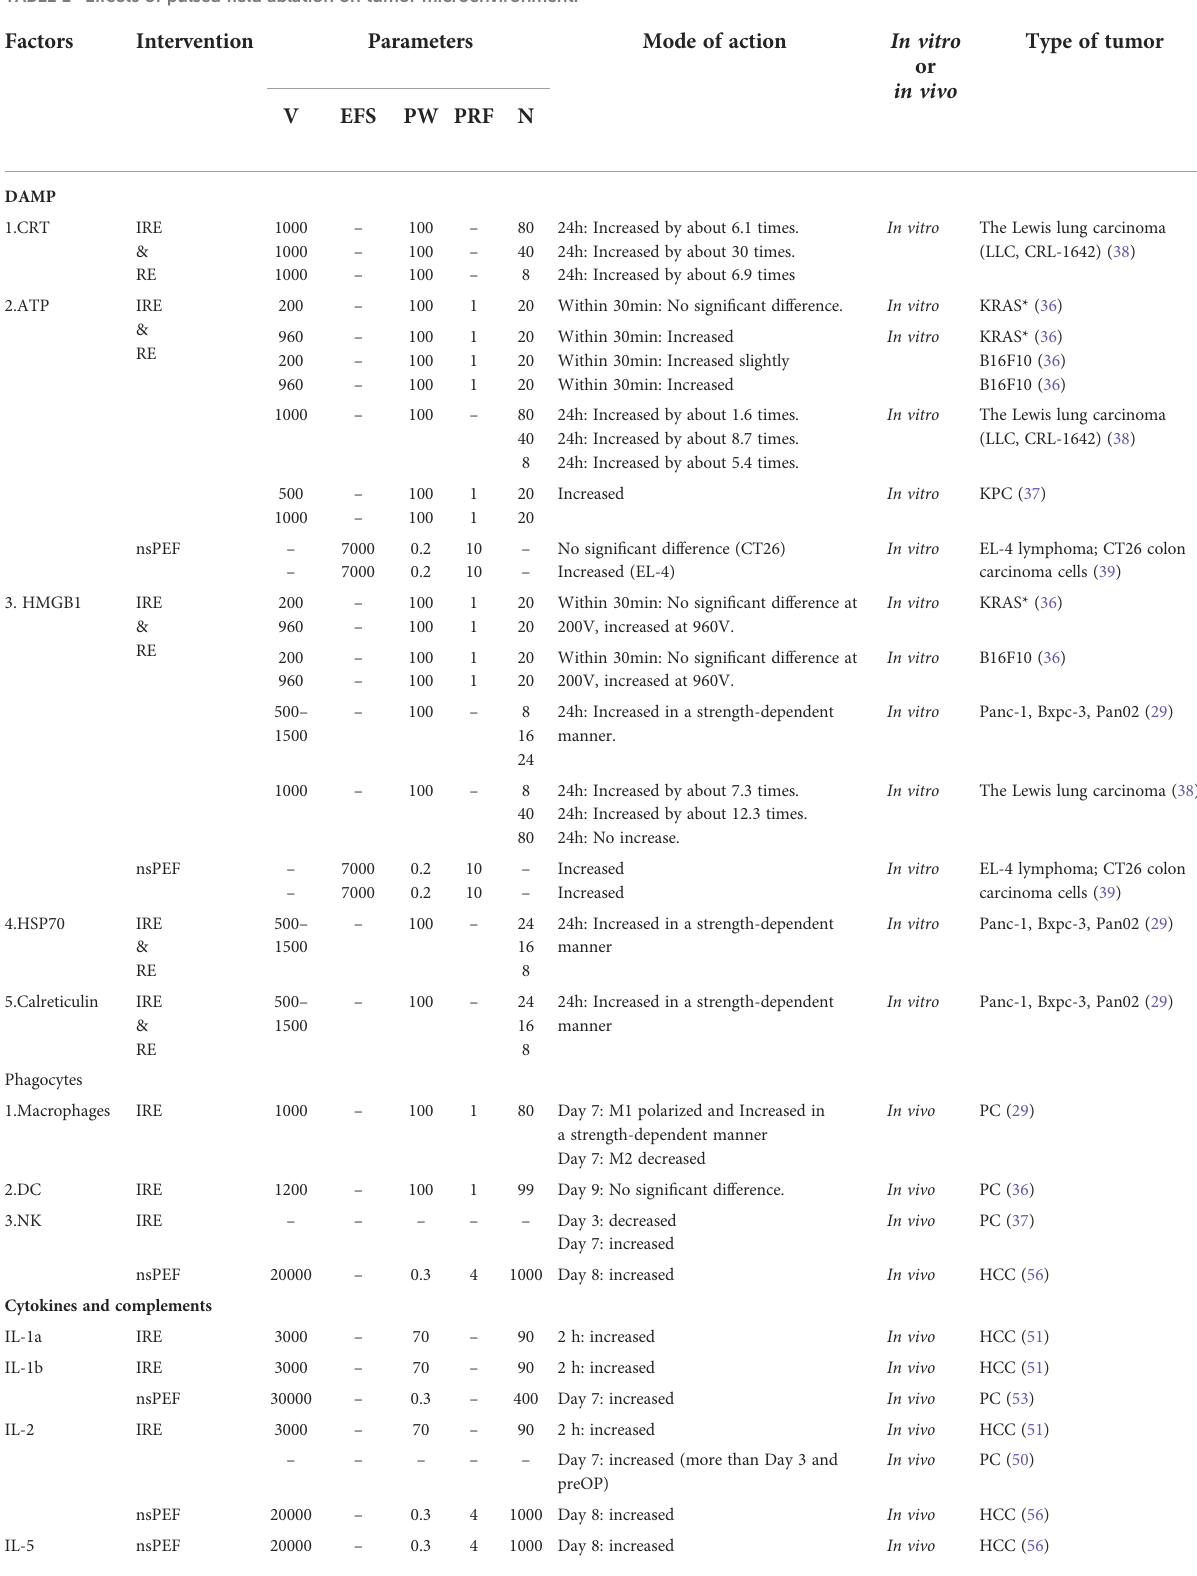
TABLE 1 Effects of pulsed fi eld ablation on tumor